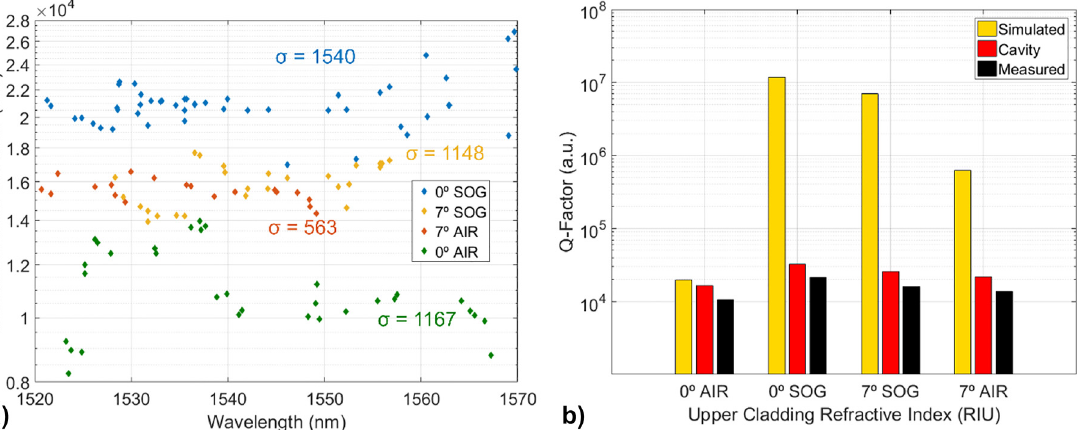
Figure 7: Experimentally measured PhC cavities, (a) Measured average Q-factor against wavelength of all the measured devices, different colours correspond to different upper-cladding and etching angle configurations: 0 ◦ – air (green), 7 ◦ – air (red), 0 ◦ – SOG (blue) and 7 ◦ – SOG (yellow). Each data point is an average of 3 devices with the same configuration operating at that wavelength (b) plot of averaged Q-factors over all the devices in the different configurations on the x -axis. The yellow bars correspond to calculated Q-factors, the red bars and the black bars to measured-factors, Q are associated to cavity Q 0 meas